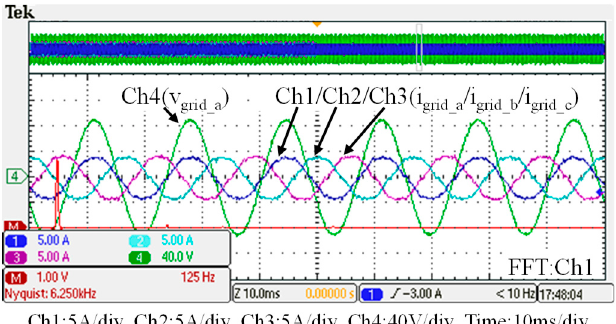
Figure 22. After t 1 : the grid phase-a voltage and three-phase currents and FFT waveform of the grid phase-a current.